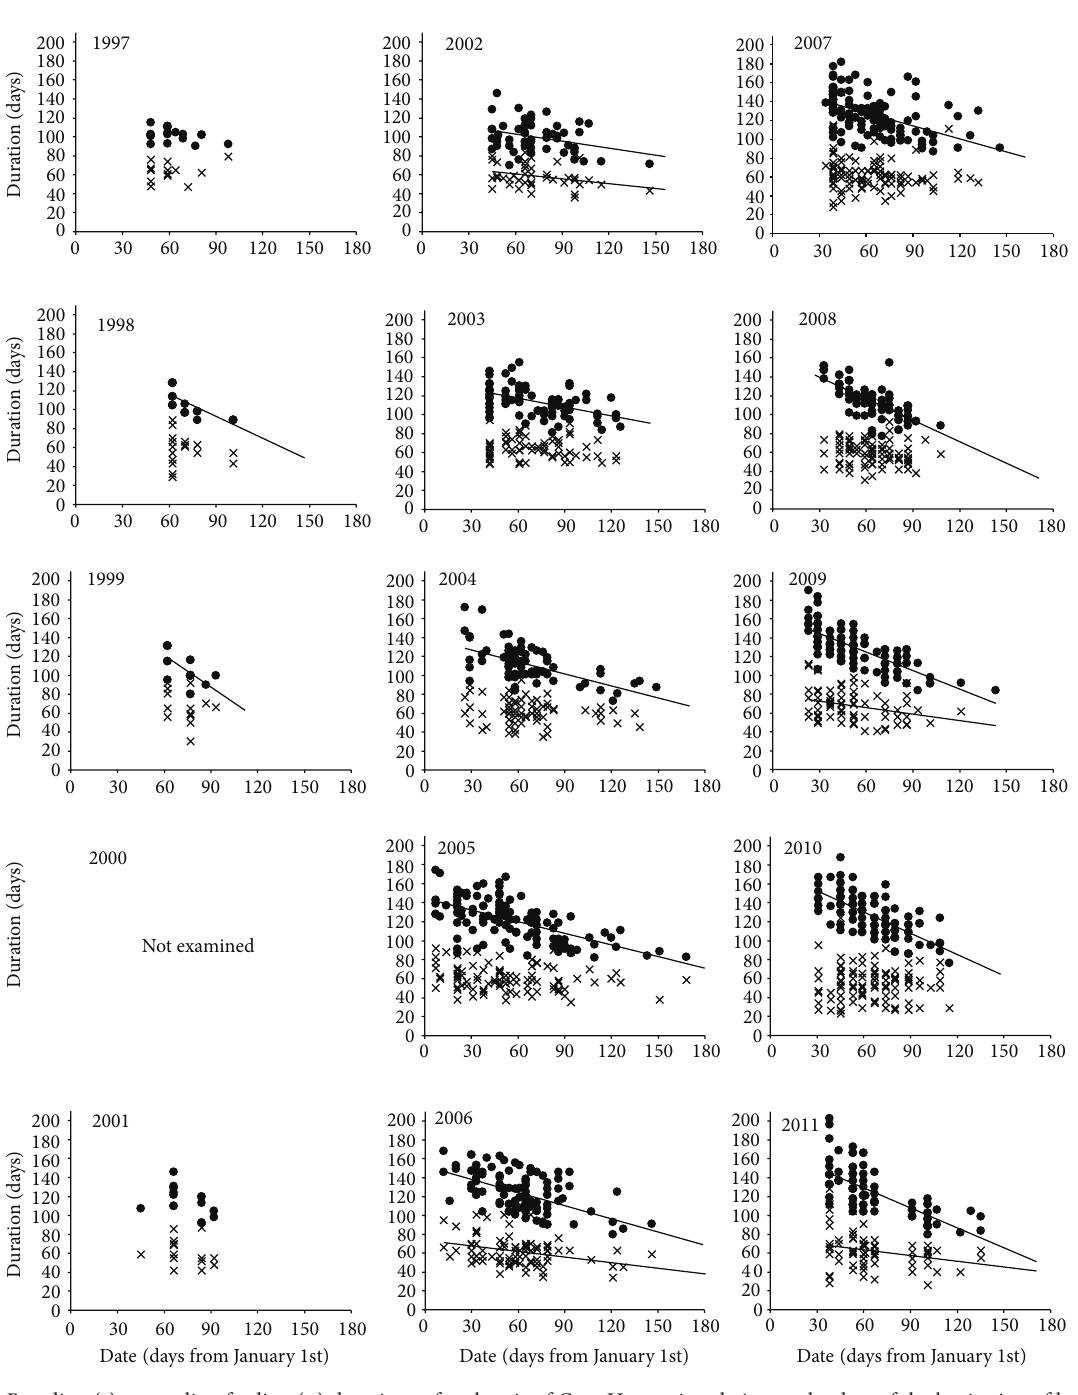
Figure 3: Breeding ( ∙ ) or nestling feeding ( × ) durations of each pair of Grey Herons in relation to the date of the beginning of breeding in each year. Regression lines are shown when the correlation coefficients are statistically significant (see Table